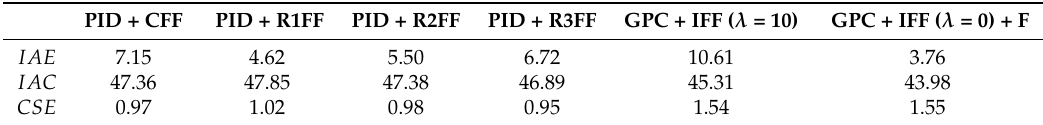
Table 3. Performance indexes for different configurations of PID and GPC feedforward control